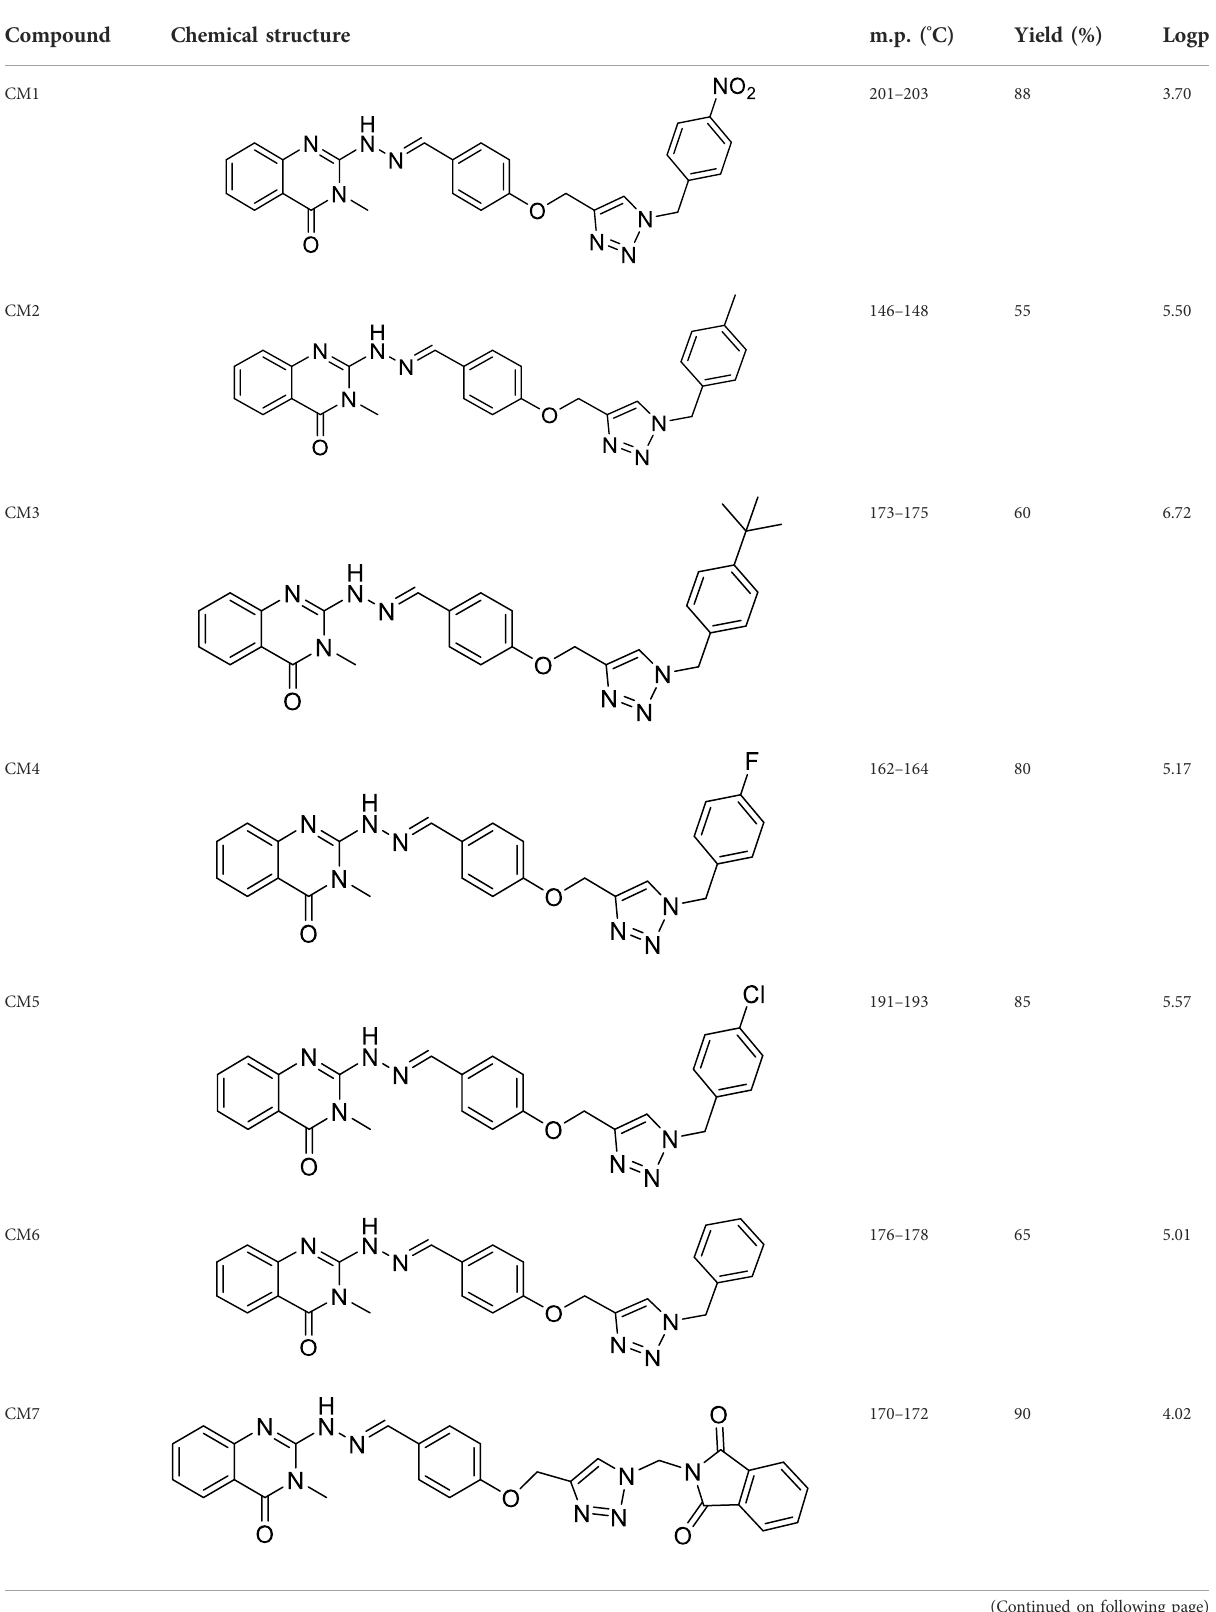
TABLE 1 Chemical and physical properties of synthesized compounds CM1 –